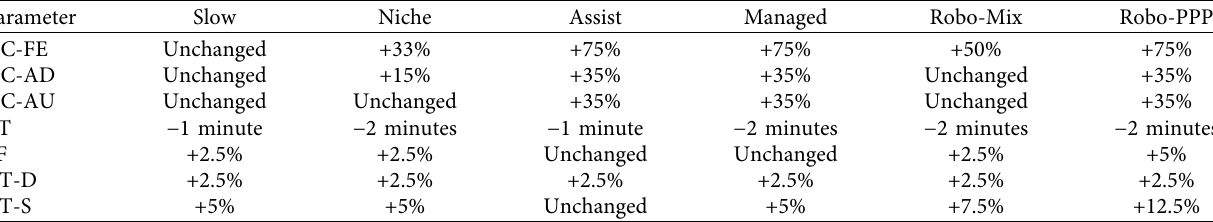
Table 3: FDOT model adjustments for CAVs adoption scenarios.